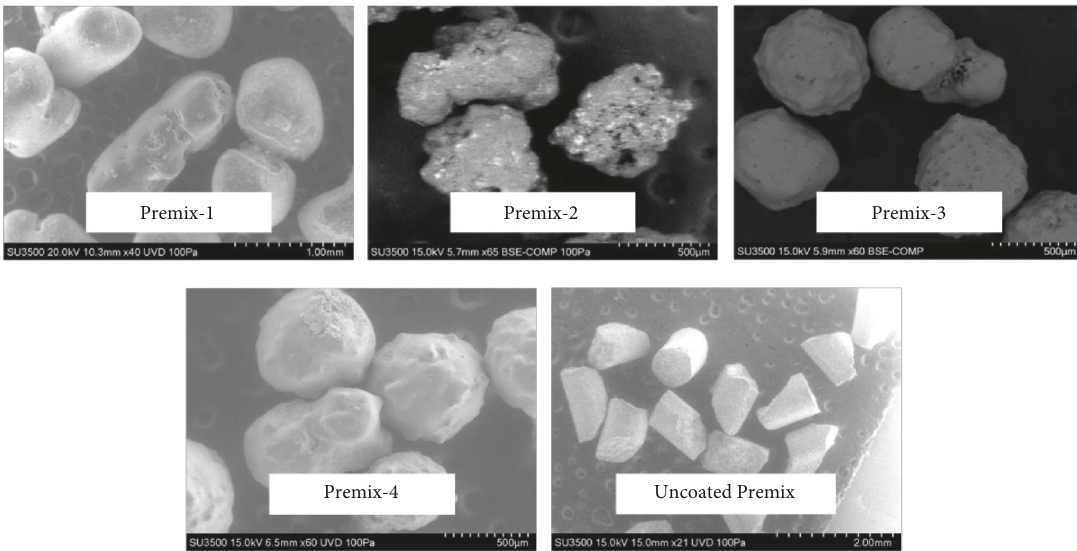
Figure 4: SEM images of Indian premixes 1–3, UofT positive control 4, and uncoated extruded ferrous fumarate.